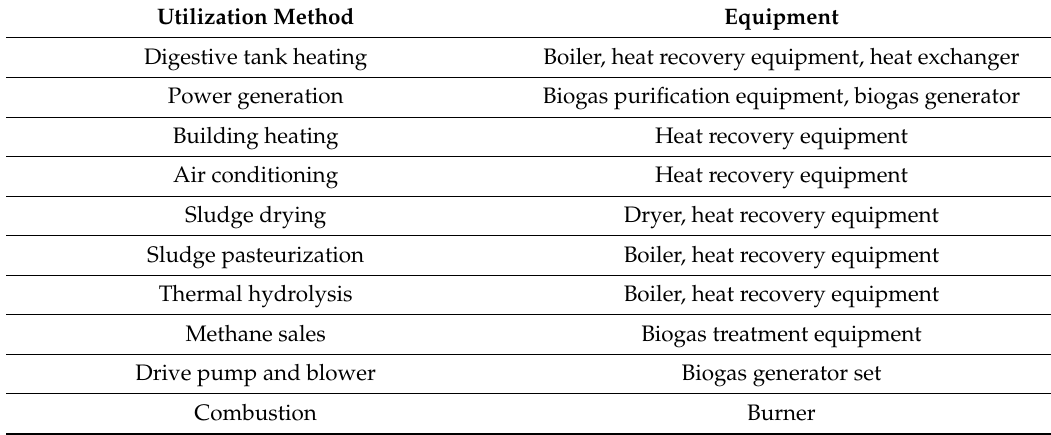
Table 1. The conventional utilization of digesting biogas.